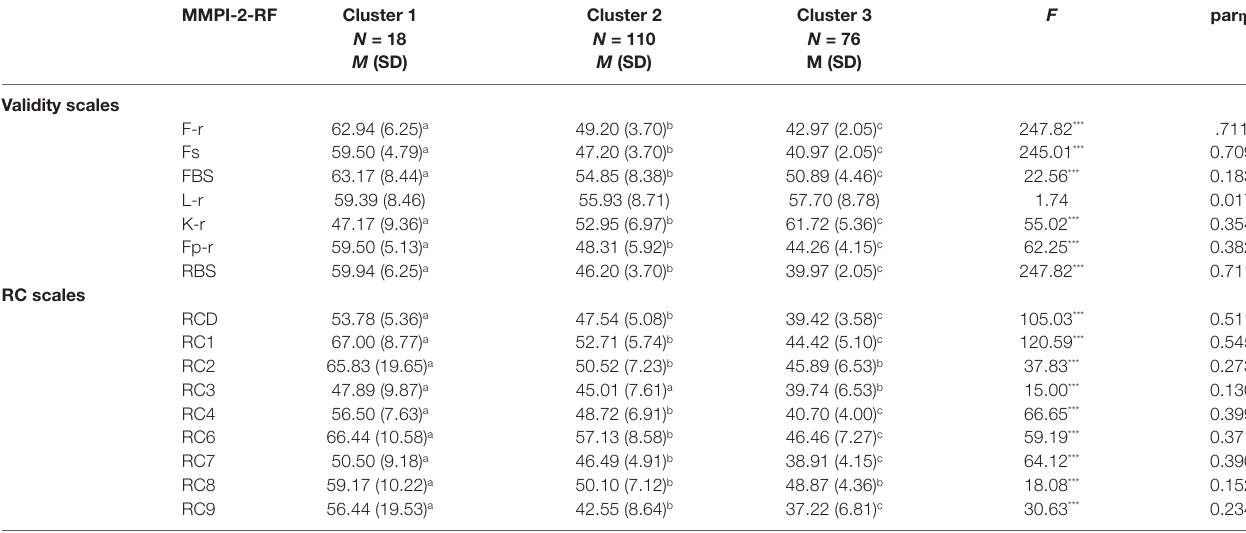
TABLE 4 | T-scores for the validity and RC scales of the MMPI-2-RF for Women-1, Women-2, and Women-3 clusters.